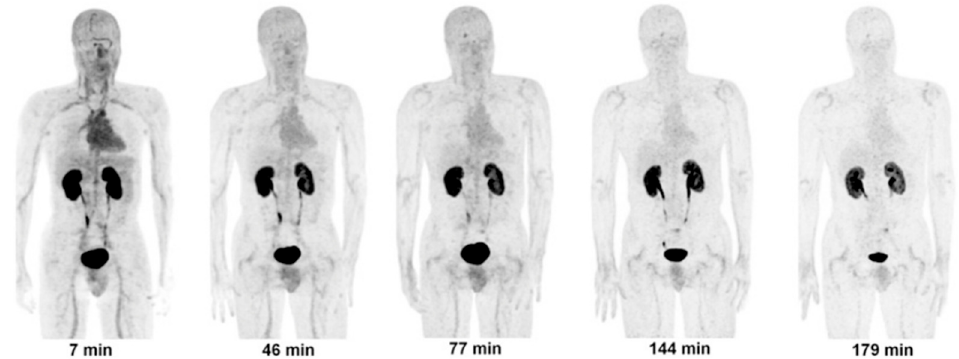
Figure 6. Decay-corrected anterior maximum-intensity projections of PET at 7, 46, 77, 144 and 179 min (from left to right) after injection of [ 18 F]CP-18 in male volunteer. There was rapid clearance of activity in all organs. Reprinted with permission from ref. [53]. Copyright 2013 SNMMI.